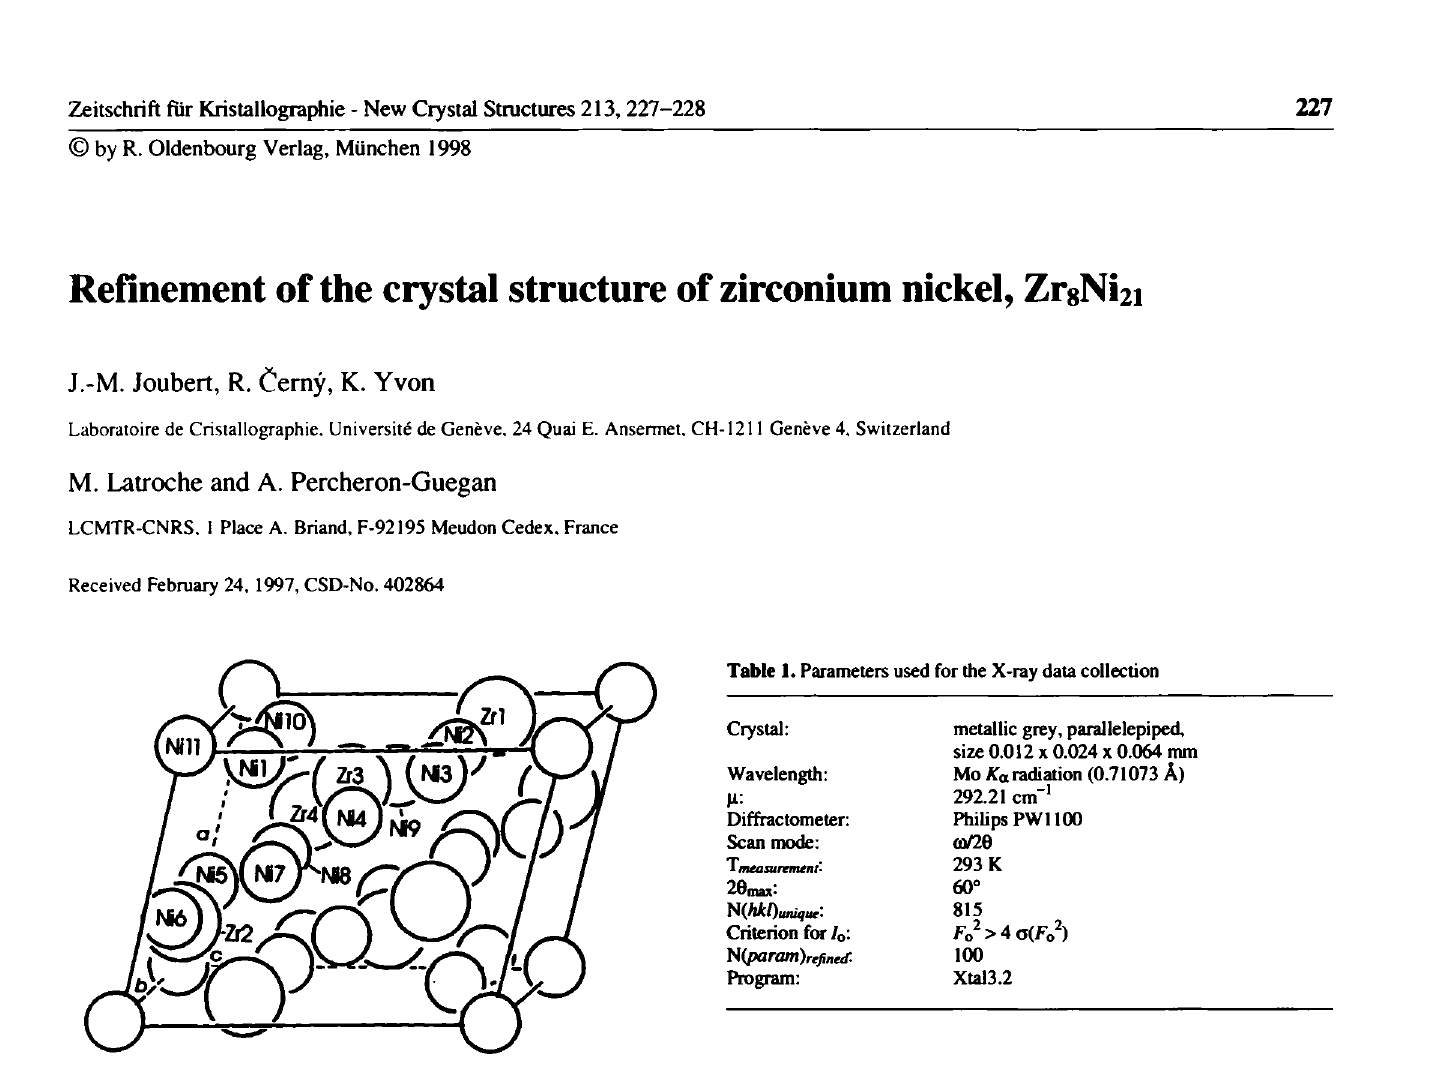
Table 1. Parameters used for the X-ray data collection